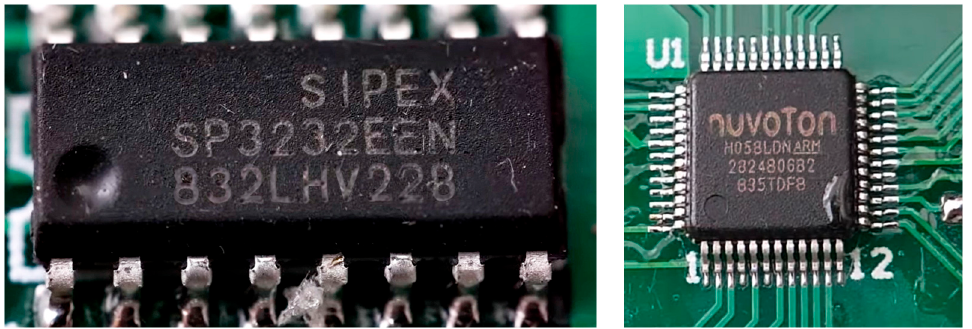
Figure 1. An SP3232EEN IC and an M058LDN 32-bit ARM Microcontroller. Both correspond to the RS-232 protocol.